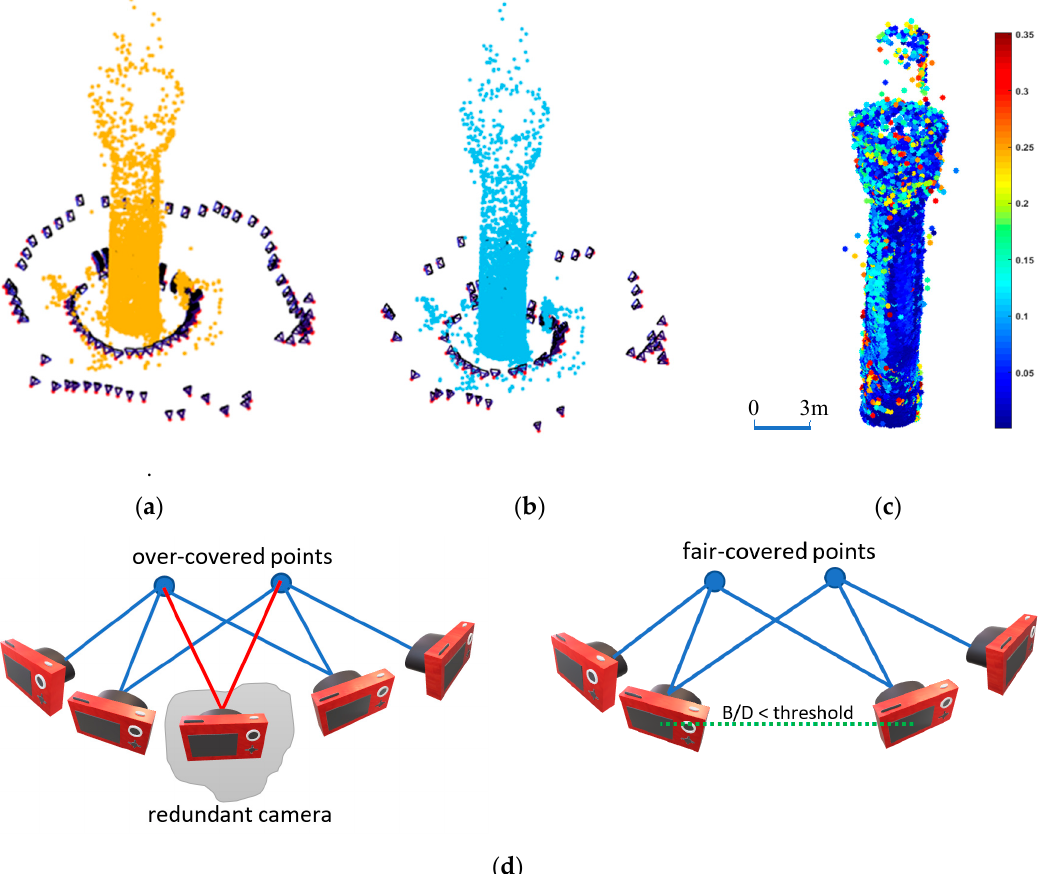
Figure 8. Imaging network around the shrine minaret. ( a ) Full imaging network with 450 images. ( b ) Filtered imaging network with 169 images. ( c ) Positional quality estimation represented in colors in cm. ( d ) The concept of filtering a redundant camera. (left) before filtering, (right) after filtering.